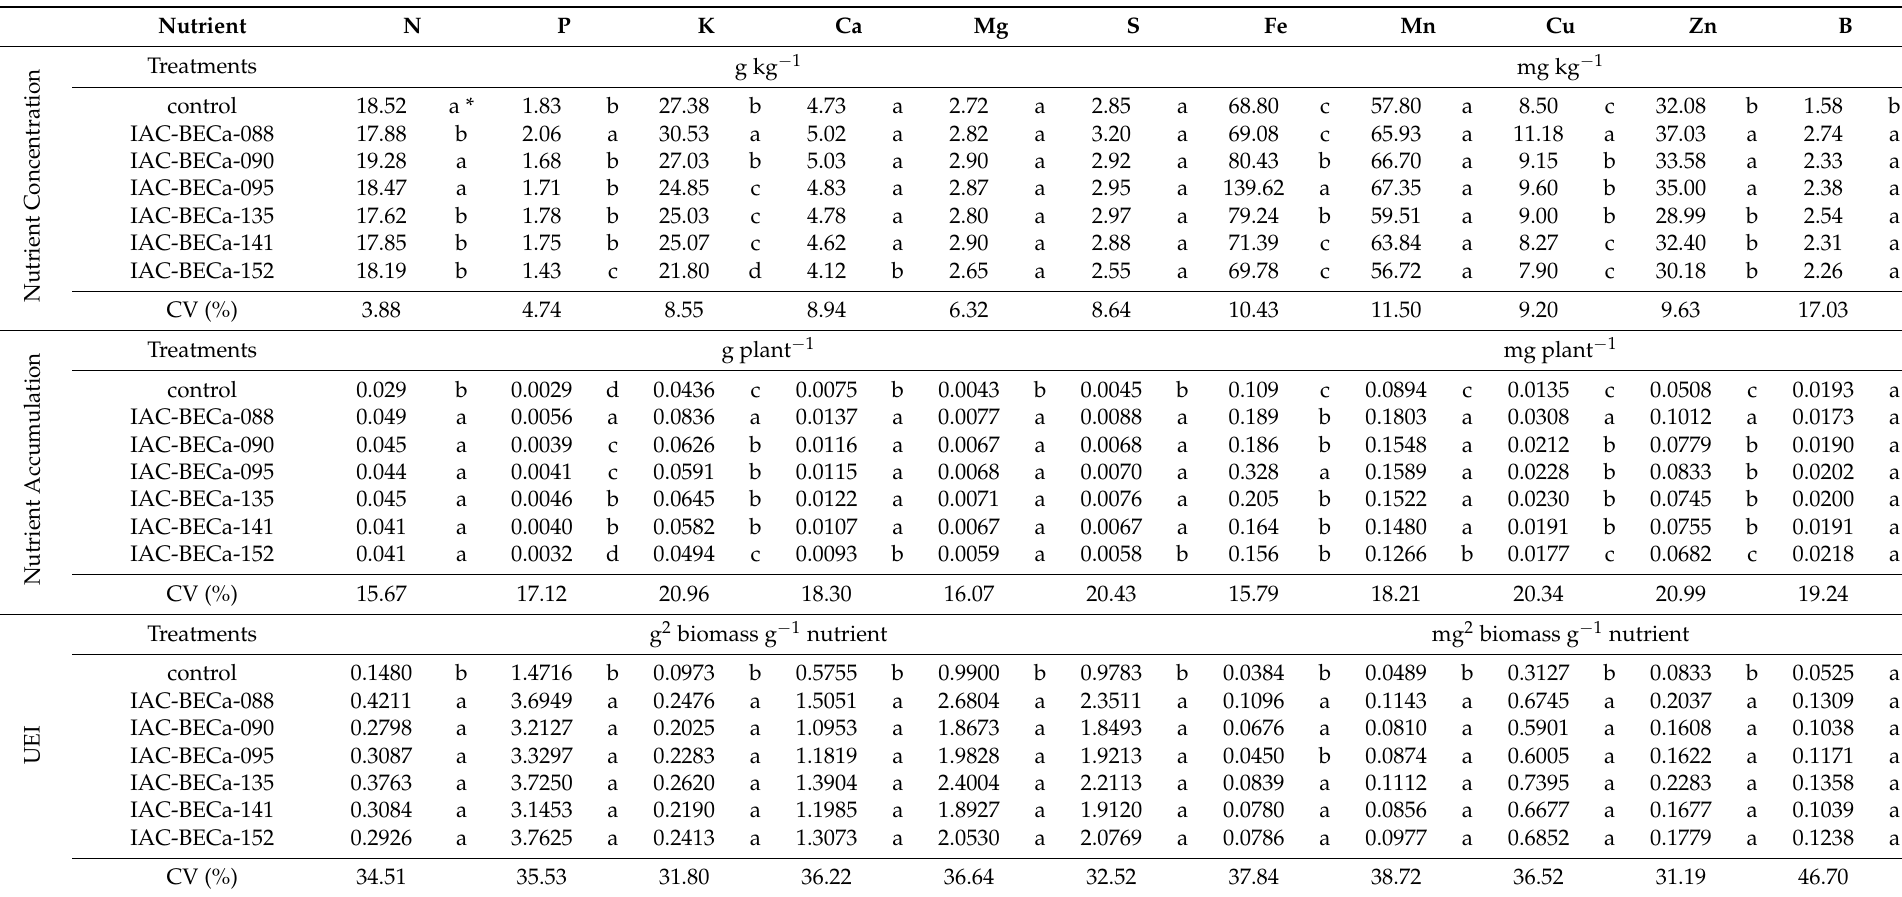
Table 3. Nutrient concentration, accumulation and nutrient-use efficiency index (UEI) of macro and micronutrients in plant shoot due to the bacterial treatments, 30 days after transplanting (T30) into the